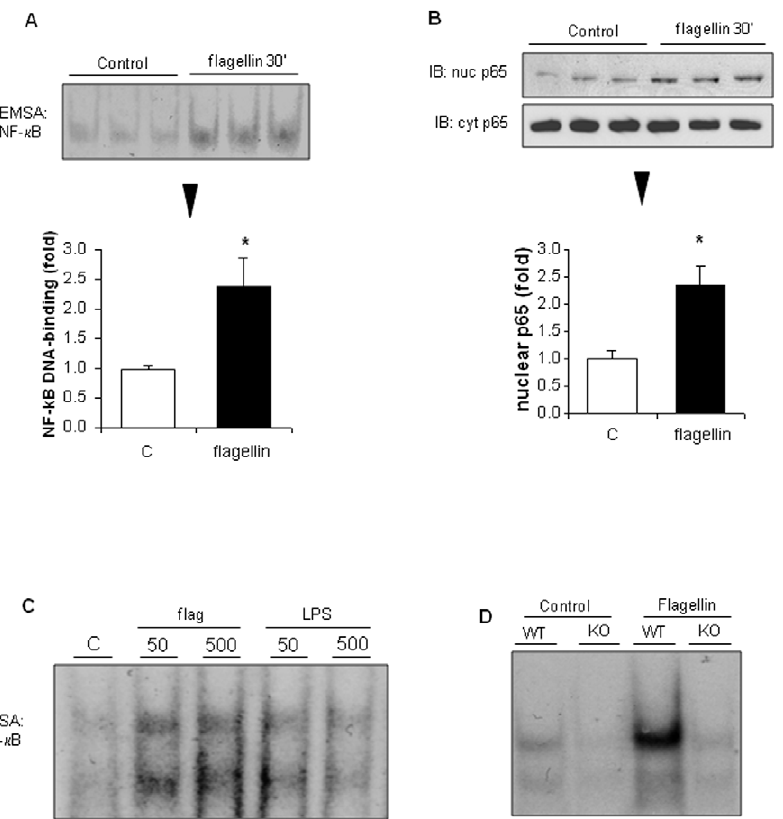
Figure 3. Flagellin activates NF- k B in primary murine cardiomyocytes via TLR5. A–B, Nuclear translocation of p65 and NF- k B-DNA binding triggered by flagellin in primary rat ventricular myocytes after 30 minutes. C, Concentration-response experiments of NF- k B-DNA binding in primary rat cardiomyocytes exposed either to flagellin or LPS (both at 50 ng/ml or 500 ng/ml) for 30 minutes. * p , 0.05 versus control C (t test).